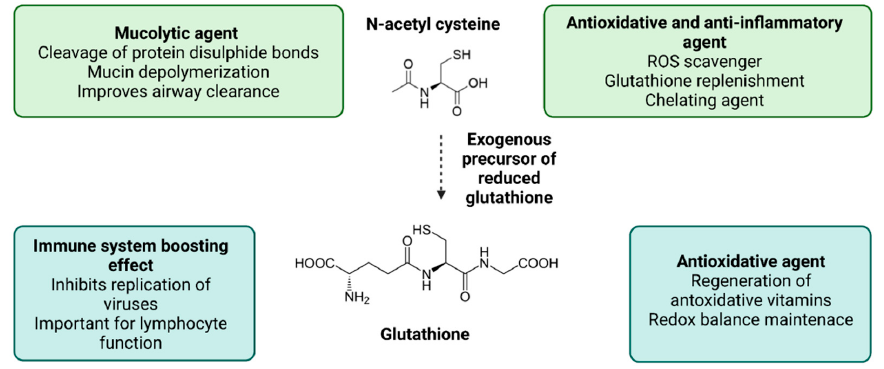
Figure 2. Glutathione and N-acetylcysteine as antioxidant and anti-inflammatory agents. Abbreviations: ROS: reactive oxygen species. Created with BioRender.com (accessed on 9 August 2022).